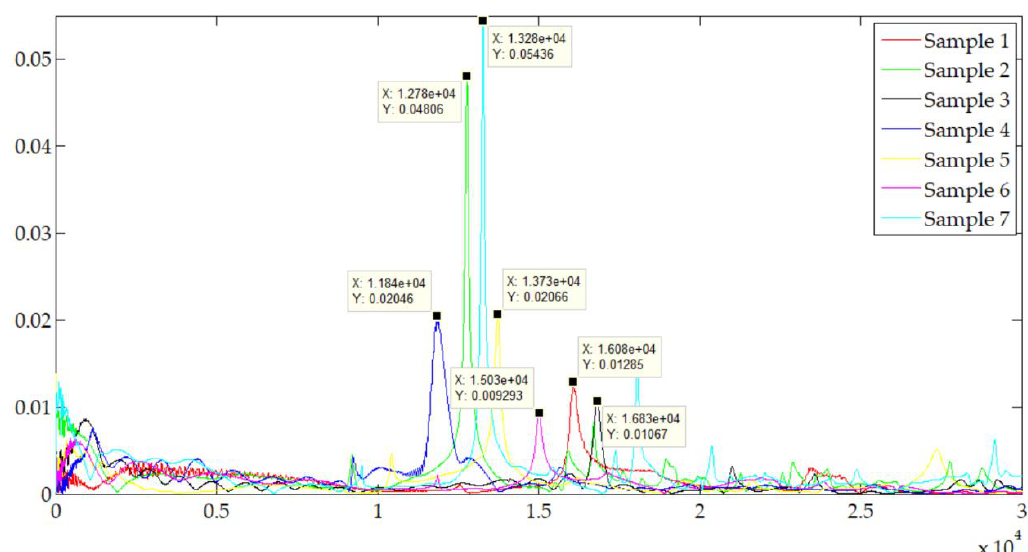
Figure 10. The results of the modal experiments.